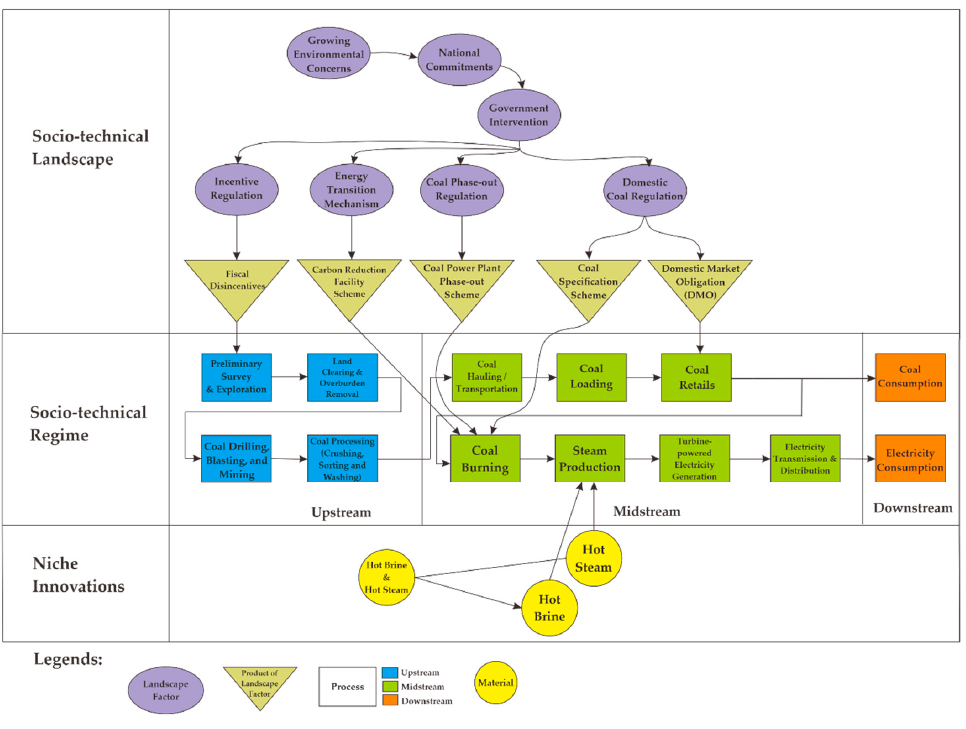
Figure 1. MLP diagram for coal energy as the old regime.